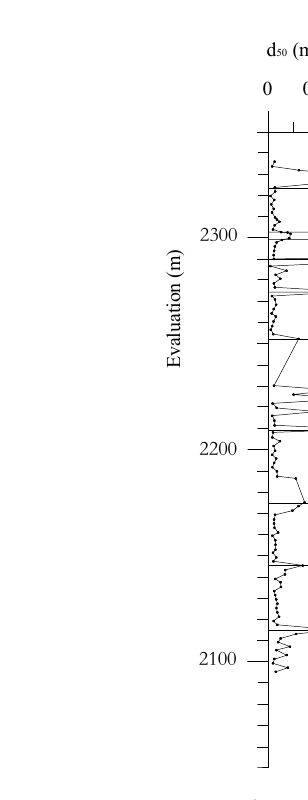
Fig. 8. Content of CaCO